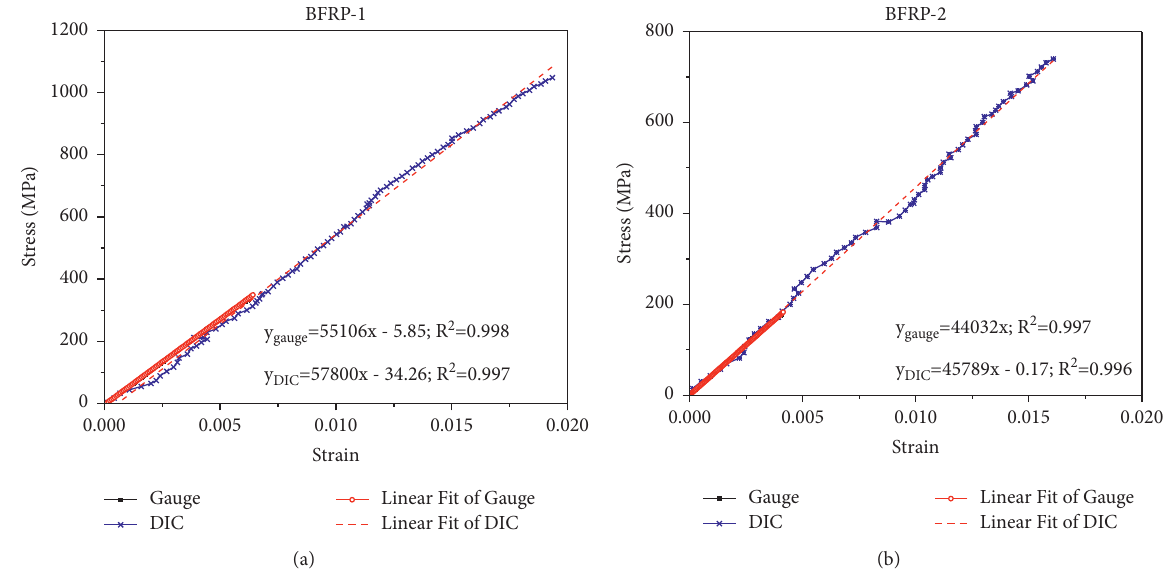
Figure 8: Stress-strain graph of BFRP grids. (a) BFRP-1. (b) BFRP-2. Table 3: Young’s modulus comparison of BFRP-1.